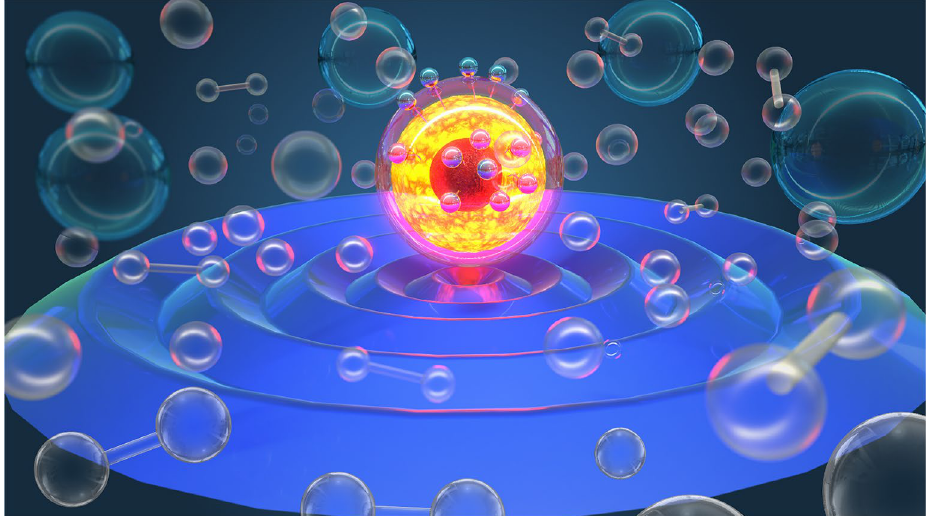
Figure 1. Graphical illustration of the scavenger process in a sonochemical reaction. The central bubble represents the cavitation bubble which achieves extremely high temperatures on collapse. Scavengers are adsorbed on the bubble surface with primary radicals being scavenged by the hydrophobic tail of the scavenger. Incomplete bubble coverage leads to recombination of primary radicals which are illustrated in the surrounding bulk solution. Illustration: George